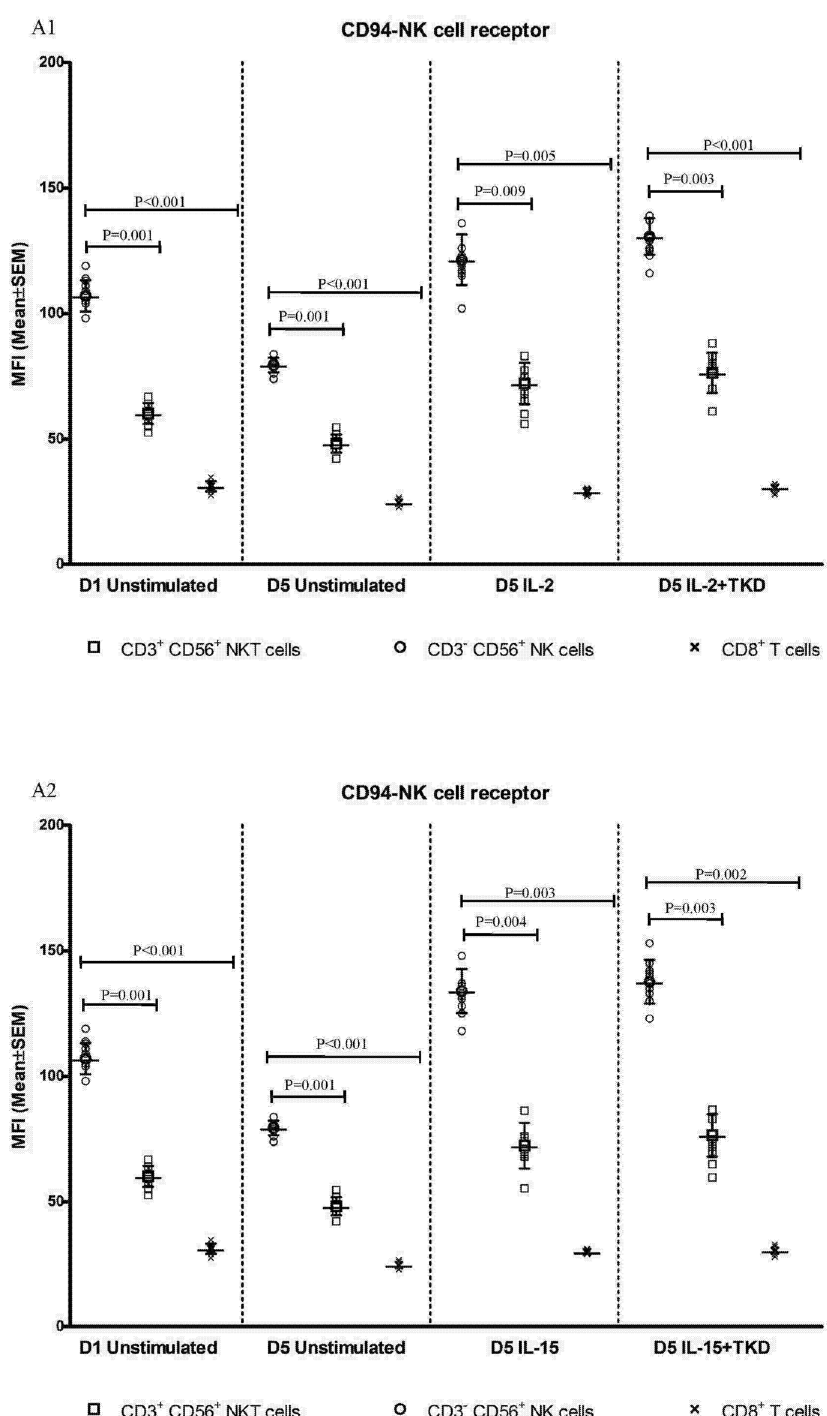
Fig 14. The effect of IL-2, IL-15, IL-2/TKD and IL-15/TKD on the expression of CD94 in peripheral blood mononuclear cells of healthy individuals — the amount of receptor expressed by CD3 - CD56 + NK cells, CD3 + CD56 + NKT cells and CD8 + T cells (the median fluorescence intensity). The amount of CD94 expressed by CD3 - CD56 + NK cells, CD3 + CD56 + NKT cells and CD8 + T cells was examined within the fraction of unstimulated and stimulated mononuclear cells derived from 10 healthy individuals. Data are presented as means ± standard error. In total, the study cohort consisted of 52 Caucasian healthy individuals.